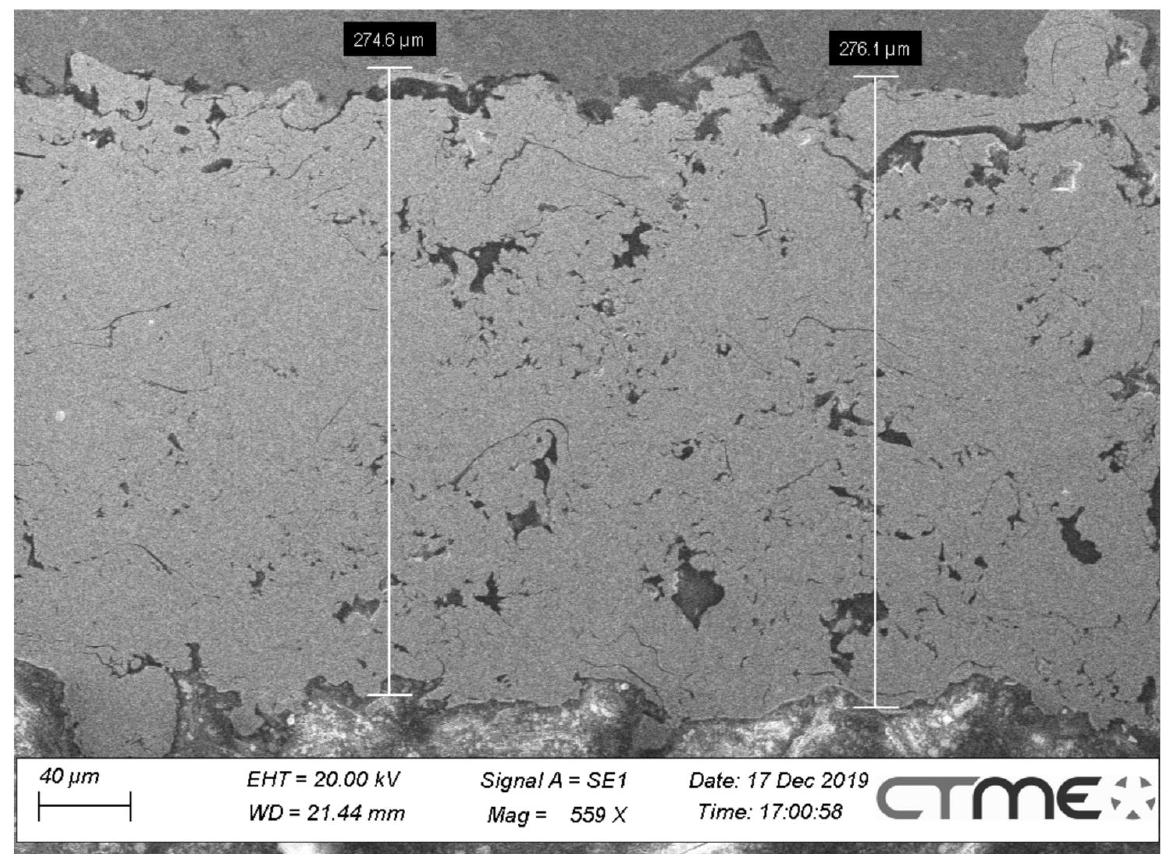
Figure 13. SEM image of the coating and the interface with the substrate for the parameter combination (Number 10). The coating thickness is also shown for two